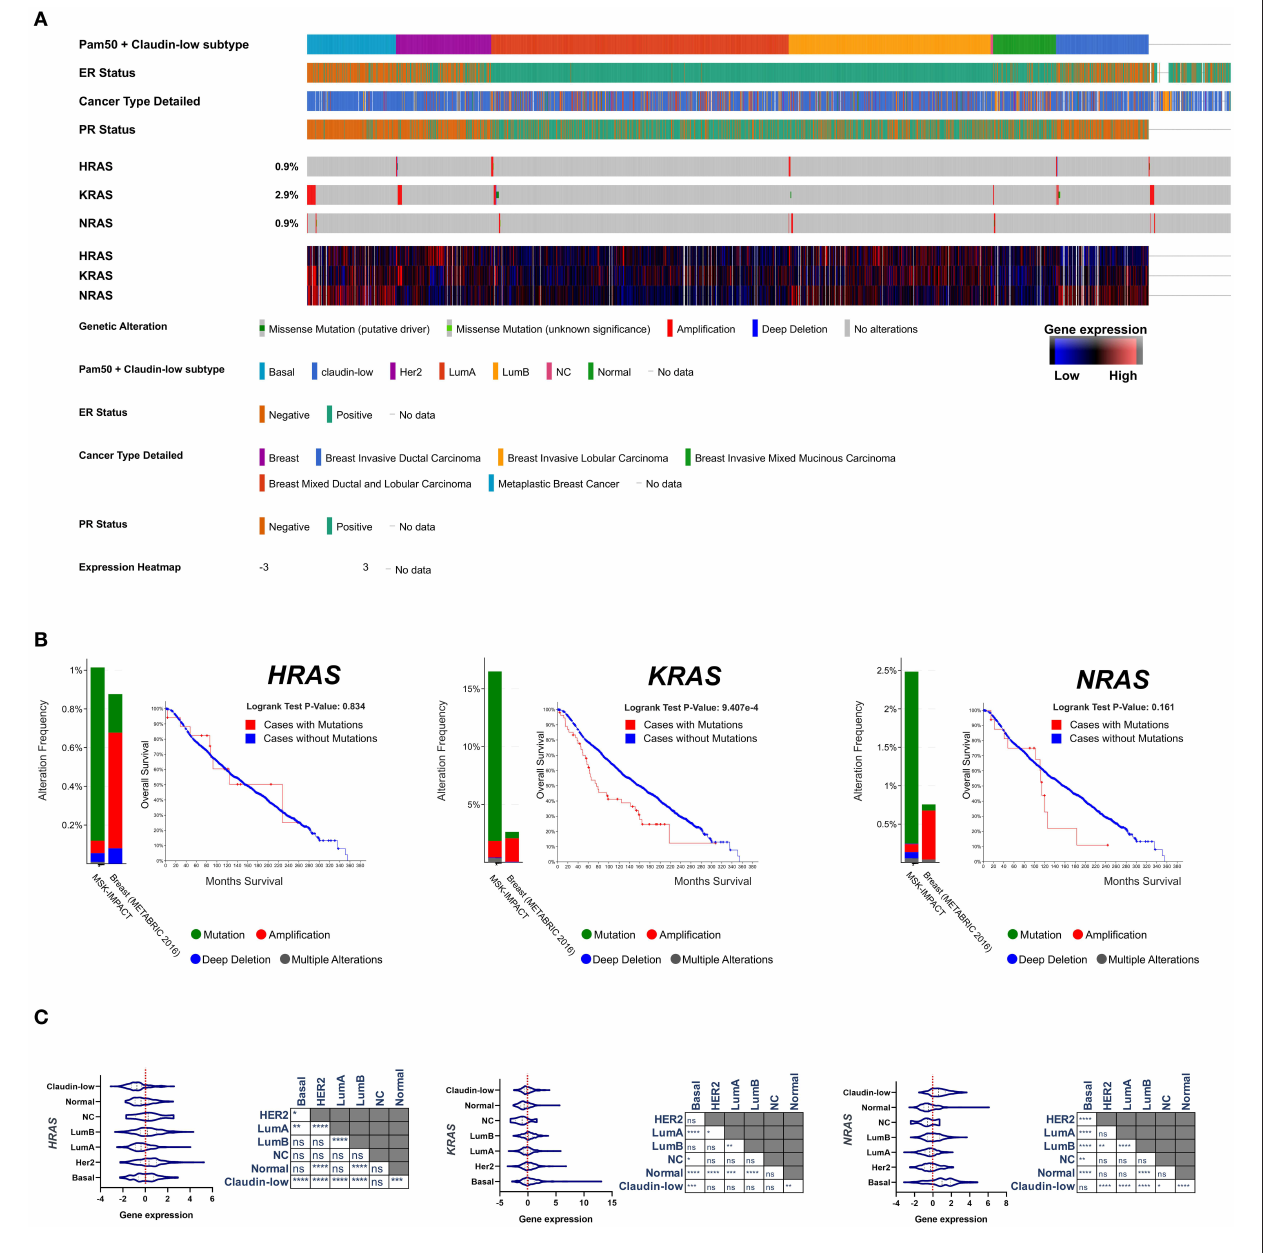
FIGURE 2 | (A) Frequency of genomic alterations and heatmap of gene expression of the RAS genes ( HRAS, KRAS, NRAS ) across 2,509 breast tumor samples of the METABRIC cohort (48), assigned to the major intrinsic subtypes (on the basis of the PAM50 profile). (B) The fraction of breast tumors (cases) with genomic alterations (METABRIC cohort, 2,509 breast tumors) of the RAS genes are reported in comparison with the fraction of tumor with genomic alteration in a pan-tumor cohort (MSK-IMPACT, 10945). Kaplan-Mayer curve are reported for each RAS isoform comparing the overall survival of the breast tumors with or without genomic alterations (METABRIC cohort, 2,509 breast tumors). (C) Gene expression level of RAS isoforms across the different subtypes of breast cancer are compared and statistically evaluated by ANOVA t -test (Turkey post-hoc ) * p < 0.05; ** p < 0.01; *** p < 0.001; **** p < 0.0001. Data have been accessed through cBioportal for Cancer Genomics website